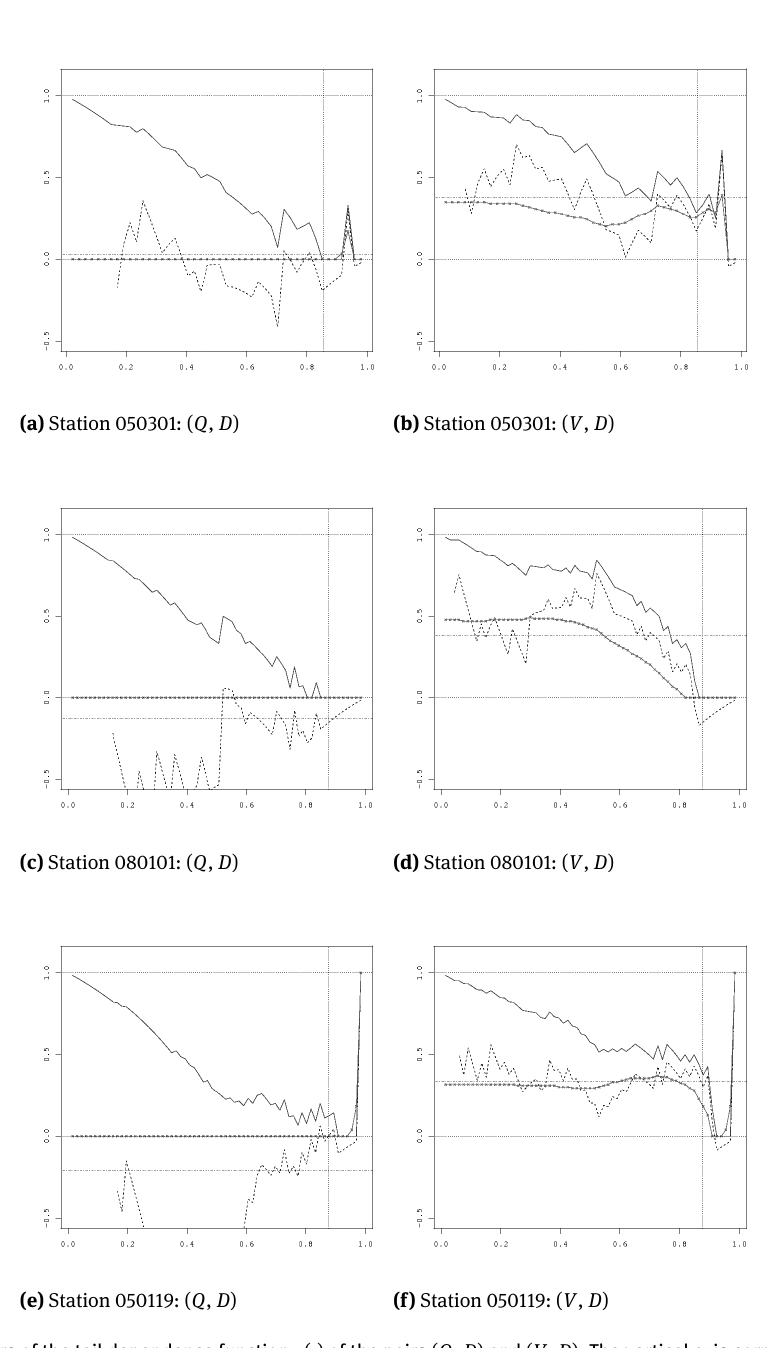
Figure 7: Estimators of the tail dependence function χ (.) of the pairs ( Q , D ) and ( V , D ) . The vertical axis corresponds to ˆ χ ( u ) with ˆ χ LOG (- - - -) and ˆ χ SEC (—), ˆ χ DF (- × - × -) and ˆ χ F (- · - · -), while the horizontal axis corresponds to thresholds U U , k u = 1/ n , 2/ n , 3/ n , . . . , 1 − 1/ n and k = n − 1, n − 2, . . . , 1 . In horizontal dotted line, the upper and lower bounds on χ (.) . In vertical dotted line, the chosen